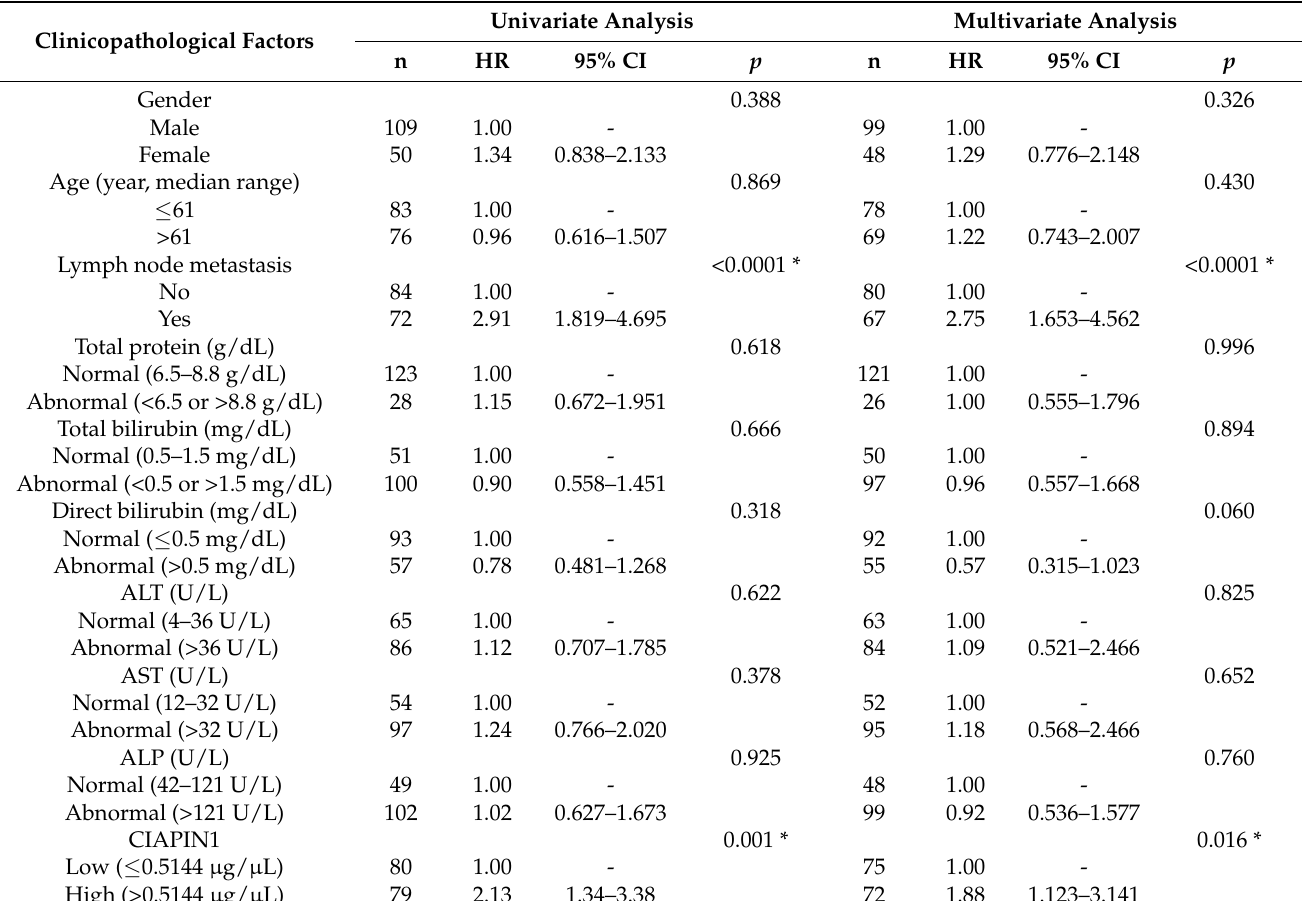
Table 3. Univariate and multivariate Cox regression analyses of clinicopathological parameters and serum CIAPIN1 levels of CCA